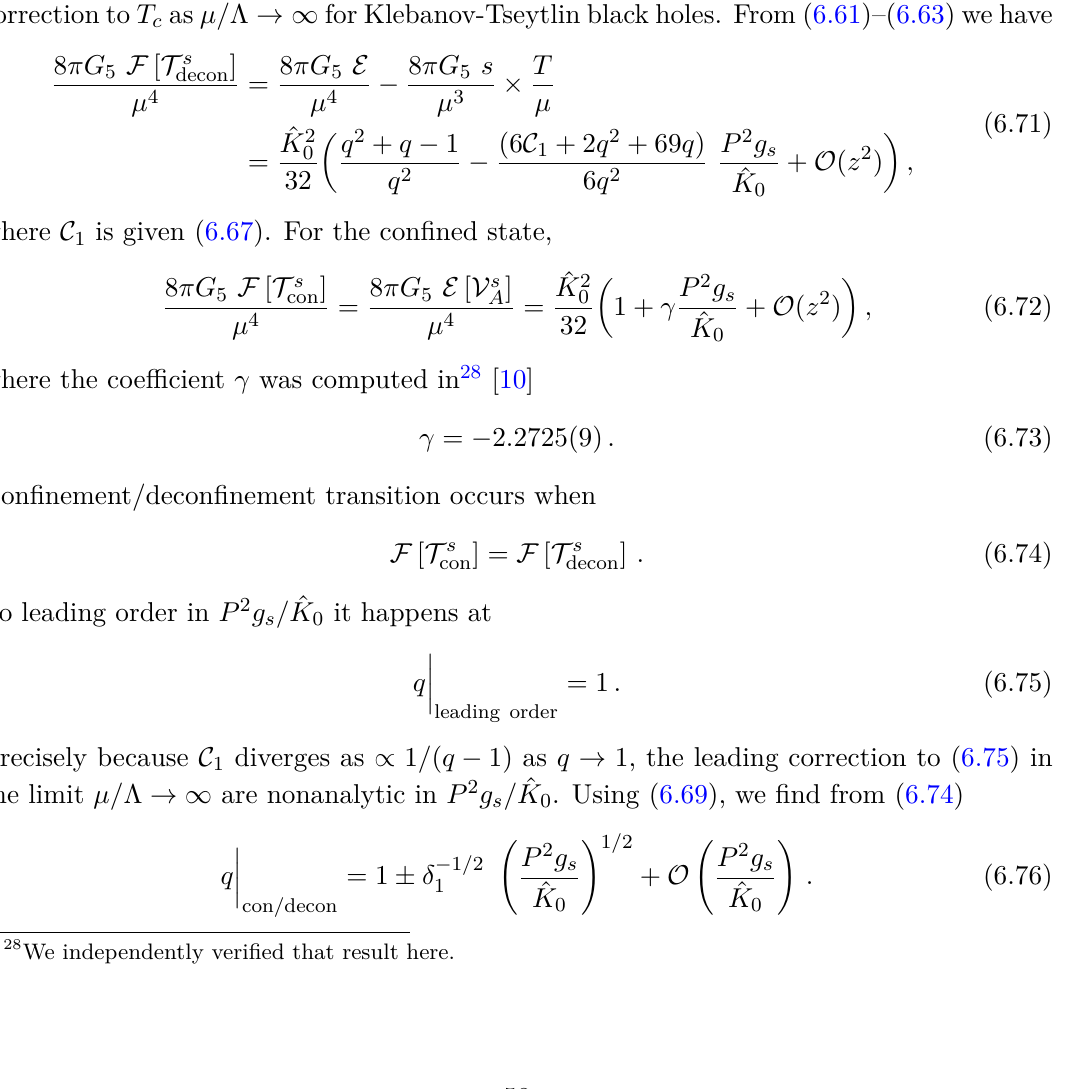
Figure 34 . Certain linear combinations of the parameters in (D.17), (the right panel, (6.68)), diverge as q C 2 1 / and 1 / at q = C 1 C 2